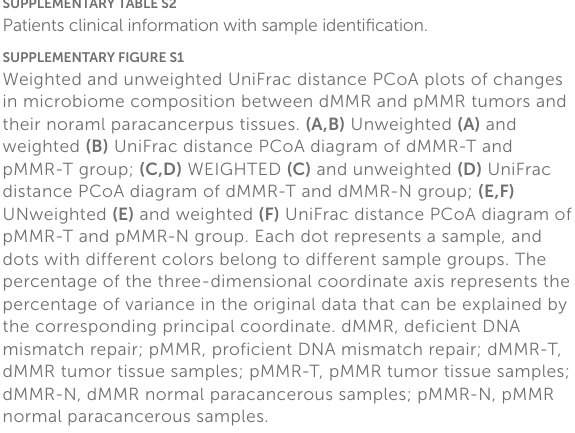
SUPPLEMENTARY FIGURE S2 Chords of dMMR and pMMR CRC tumor samples-species abundance association. Circos analysis directly reflecting the composition proportion of dominant species in each sample at the species level and the distribution proportion of dominant species in different samples. dMMR, deficient DNA mismatch repair; pMMR, proficient DNA mismatch repair. SUPPLEMENTARY FIGURE S3 Comparison of firmicutes/Bacteroidetes ratios between groups. Comparative analysis of firmicutes/Bacteroidetes ratio between dMMR-T and pMMR-T group (A), between dMMR-T and dMMR-N group (left), and between pMMR-T(middle) and pMMR-N group (right). dMMR, deficient DNA mismatch repair; pMMR, proficient DNA mismatch repair; dMMR-T, dMMR tumor tissue samples; pMMR-T, pMMR tumor tissue samples; dMMR-N, dMMR normal paracancerous samples; pMMR-N, pMMR normal paracancerous samples. SUPPLEMENTARY FIGURE S4 Cluster heat map of relative abundance of different genera in dMMR and pMMR tumor tissues at genus level. The color depth represents the relative abundance of different bacteria. Strong yellow indicates high relative abundance of the genus, while light blue indicates absence of the genus. The abscissa is the number of included samples, and the ordinate is the name of the different bacteria genus. SUPPLEMENTARY FIGURE S5 Heat map of relative abundance of the genera in dMMR-T and dMMR-N tissues. The color depth represents the relative abundance of different bacteria. The abscissa is the number of included samples, and the ordinate is the name of the different bacteria genus. dMMR, deficient DNA mismatch repair; dMMR-T, dMMR tumor tissue samples; dMMR-N, dMMR normal paracancerous samples. SUPPLEMENTARY FIGURE S6 Box plot of the top 20 differences in relative abundance of intestinal genera between dMMR-T and dMMR-N group. dMMR, deficient DNA mismatch repair; dMMR-T, dMMR tumor tissue samples; dMMR-N, dMMR normal paracancerous samples. SUPPLEMENTARY FIGURE S7 Heat map of relative abundance of different genera in pMMR-T and pMMR-N tissues. The color depth represents the relative abundance of different bacteria. The abscissa is the number of included samples, and the ordinate is the name of the different bacteria genus. pMMR, proficient DNA mismatch repair; pMMR-T, dMMR tumor tissue samples; pMMR-N, dMMR normal paracancerous samples. SUPPLEMENTARY FIGURE S8 Box plot of top 20 differences in relative abundance of intestinal genera between pMMR-T and pMMR-N. pMMR, proficient DNA mismatch repair; pMMR-T, dMMR tumor tissue samples; pMMR-N, dMMR normal paracancerous samples. SUPPLEMENTARY FIGURE S9 Phylogenetic branching of bacterial enrichment in dMMR and pMMR tumor samples. The brightness of each point is proportional to its effect size. Taxonomic levels from phylum to genus are indicated by large circles in the center (P: phylum; C: class; O: order; F: Family; G: genus). The diameter of each circle indicates the relative abundance of the flora. dMMR, deficient DNA mismatch repair; pMMR, proficient DNA mismatch repair. SUPPLEMENTARY FIGURE S10 Phylogenetic branching of bacterial enrichment in dMMR-T and dMMR -N. The brightness of each point is proportional to its effect size. Taxonomic levels from phylum to genus are indicated by large circles in the center (P: phylum; C: class; O: order; F: Family; G: genus). The diameter of each circle indicates the relative abundance of the flora. dMMR, deficient DNA mismatch repair; dMMR-T, dMMR tumor tissue samples; dMMR-N, dMMR normal paracancerous samples. SUPPLEMENTARY FIGURE S11 Phylogenetic branching of bacterial enrichment in pMMR-T and pMMR-N. The brightness of each point is proportional to its effect size. Taxonomic levels from phylum to genus are indicated by large circles in the center (P: phylum; C: class; O: order; F: Family; G: genus). The diameter of each circle indicates the relative abundance of the flora. pMMR, proficient DNA mismatch repair; pMMR-T, dMMR tumor tissue samples; pMMR-N, dMMR normal paracancerous